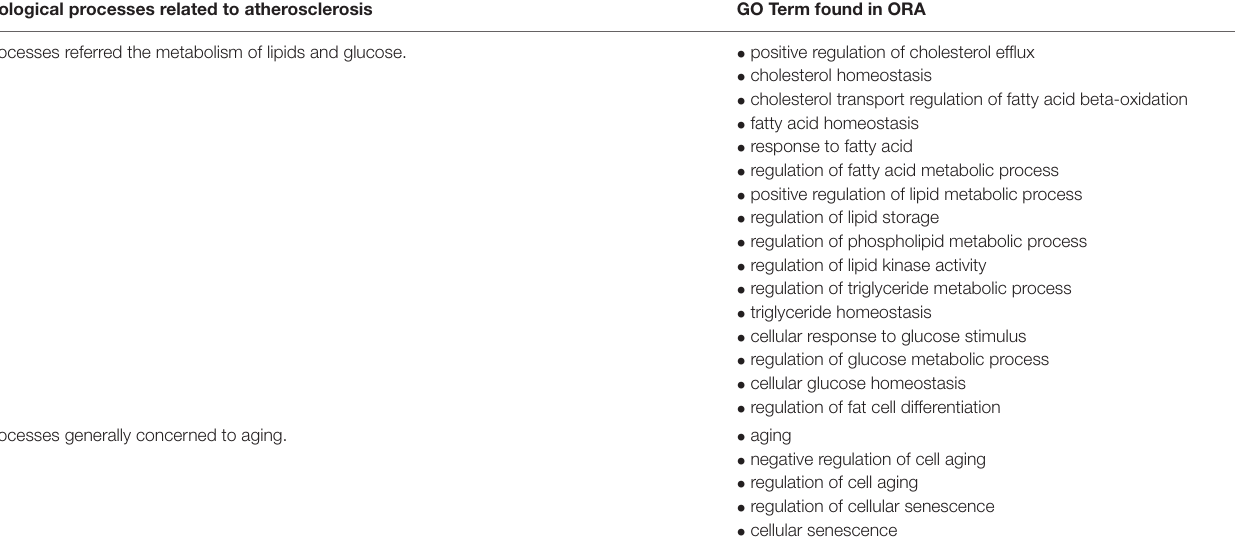
Biological processes related to atherosclerosis GO Term found in ORA Processes referred the metabolism of lipids and